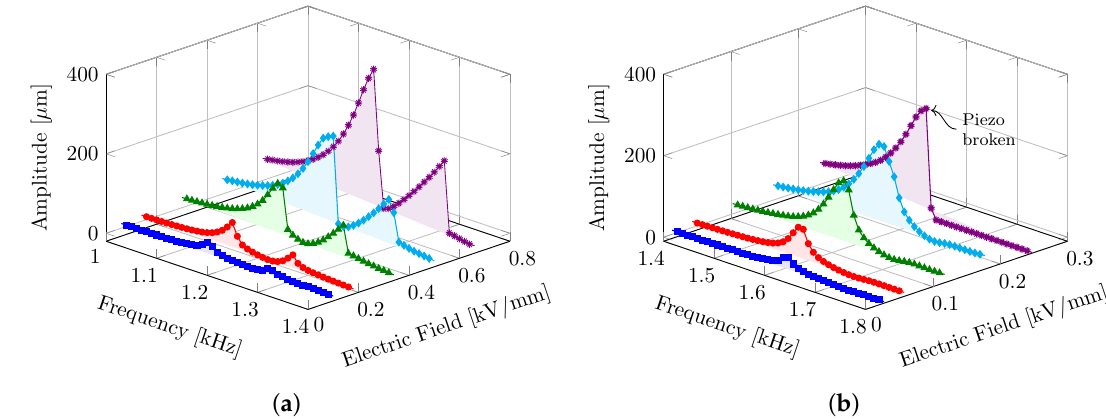
Figure 7. Frequency sweeps with increasing electric field strengths for transducer configurations with piezo elements near the edges ( ∆ B = 1 mm—( a )) and at the center ( ∆ B = 6 mm—( b )) of the